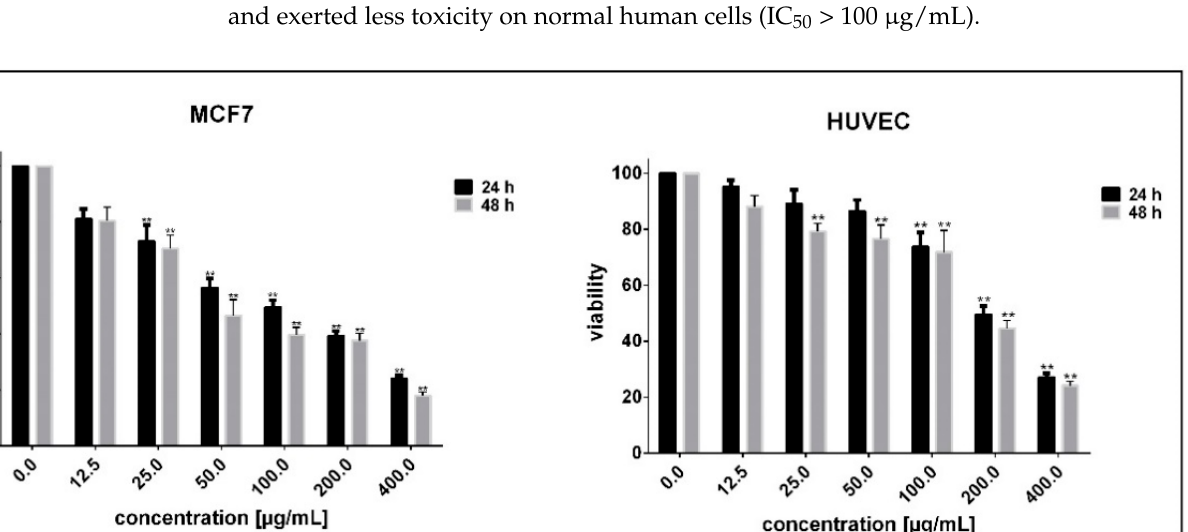
Figure 3. The magnetic hysteresis loops of the prepared samples.